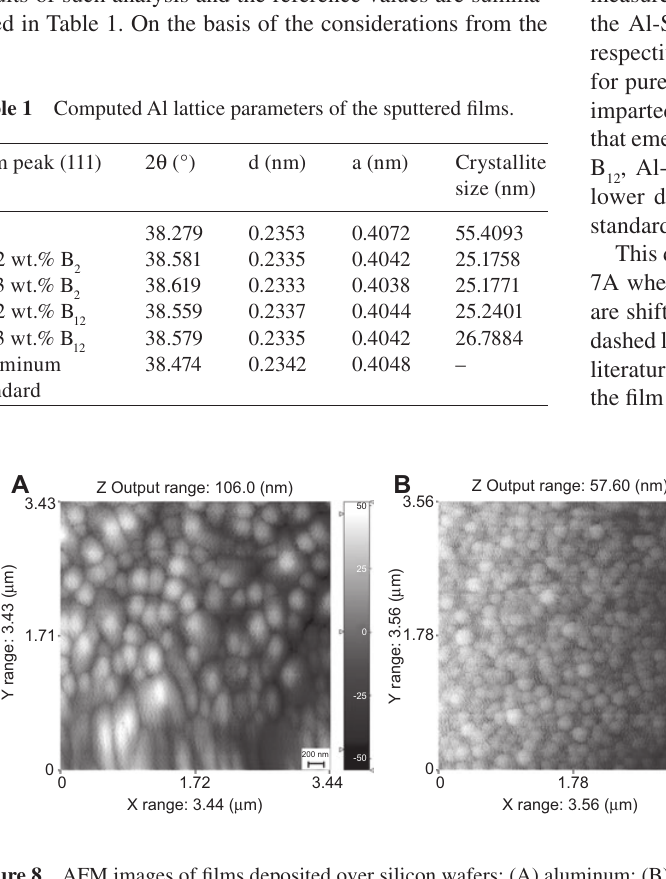
; (C) Al-Si/3 wt. % B . 2 12